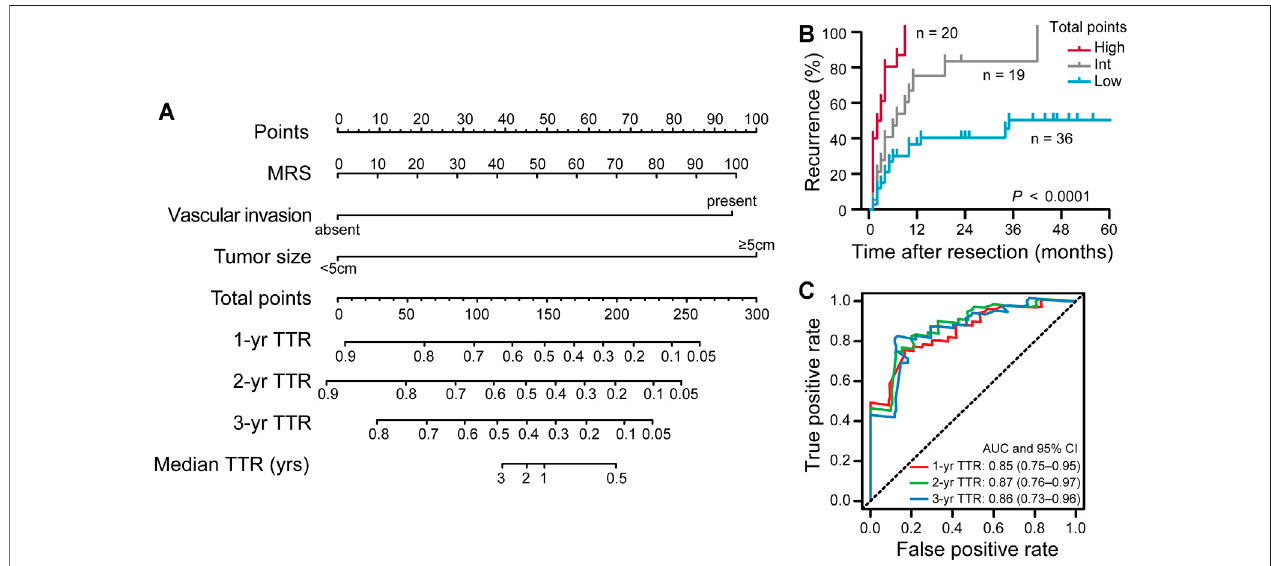
FIGURE3| TheconstructionandprognosticperformanceoftheMRS-basednomogram. (A) TheMRS-basednomogramforpredictingtimetorecurrenceofiCCA afterresection. (B) Kaplan-MeiersurvivalanalysisofTTRaccordingtothetotalpointsgivenbythenomogram.Patientsweredividedintothreesubgroups(Low:0 – 191.3; Int: 191.3 – 328.4; High: 238.4 – 300) based on cutoff scores generated by X-tile program ( Supplementary Figure S2 ). (C) ROC curve analysis showed the discriminatory ability of MRS-based nomogram for predicting 1, 2, and 3 years recurrence of iCCA after resection. The area under curve (AUC) was shown as the mean and